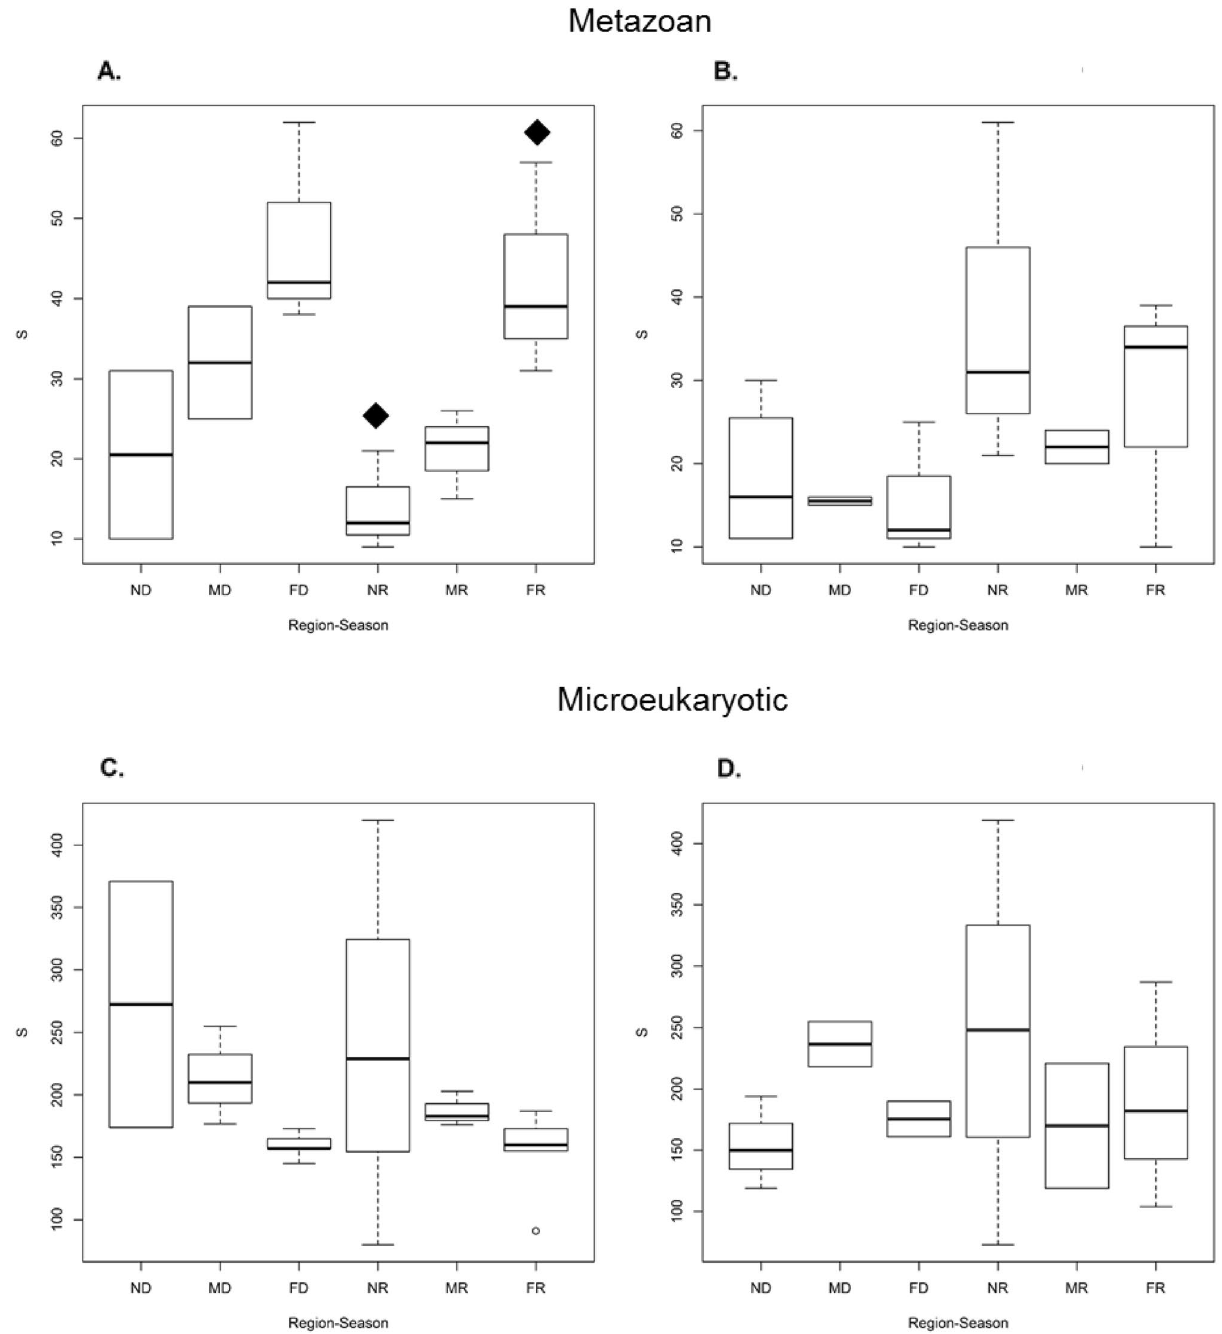
Figure 4. Boxplots for alpha diversity-richness (S) comparisons of metazoan and micro-eukaryotic communities between the lagoon systems: Metazoans ( A ) CH, ( B ) C; microeukaryotic ( C ) CH, ( D ) C. Filled diamond indicates significant differences between the pairs of regions analysed (ANOVA, F2,6 = 7.926, p = 0.0207), (Tukey HDS, p = 0.0205). On the x-axis (Season-Region) the first letter indicates the region (N, M and F) and the second letter indicates the season (D and R). On the Y axis, the richness of MOTUs is